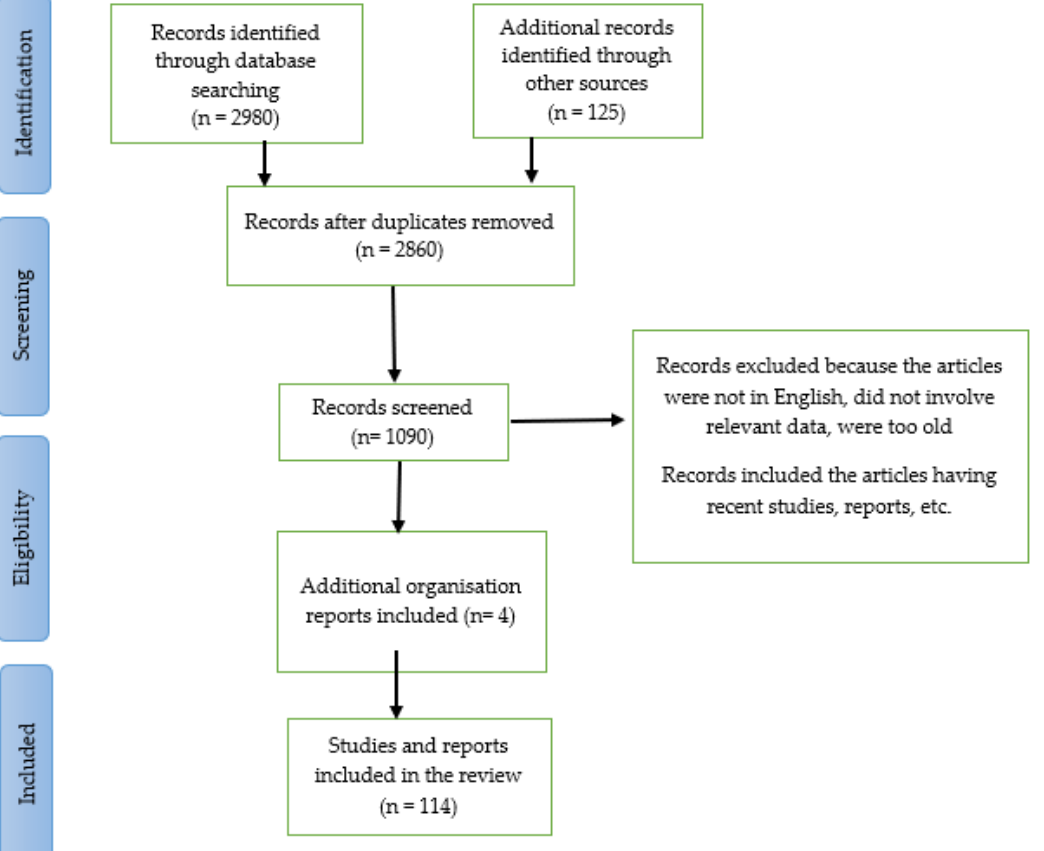
Figure 1. Work flow of this review and systematic